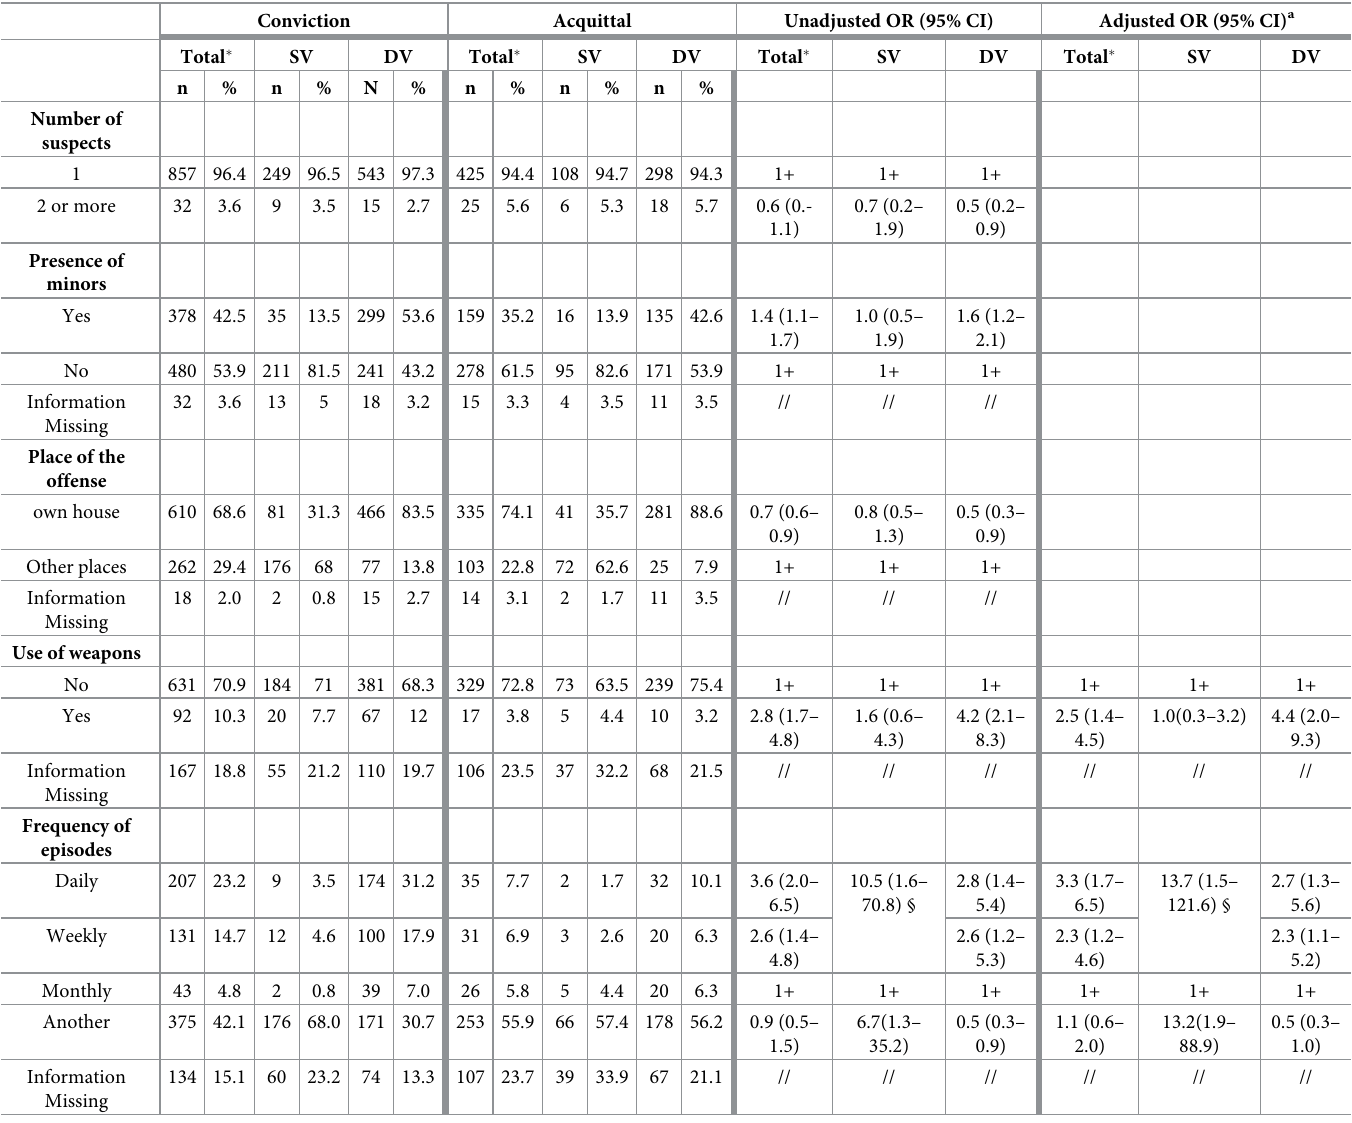
Table 5. Distribution of characteristics of the